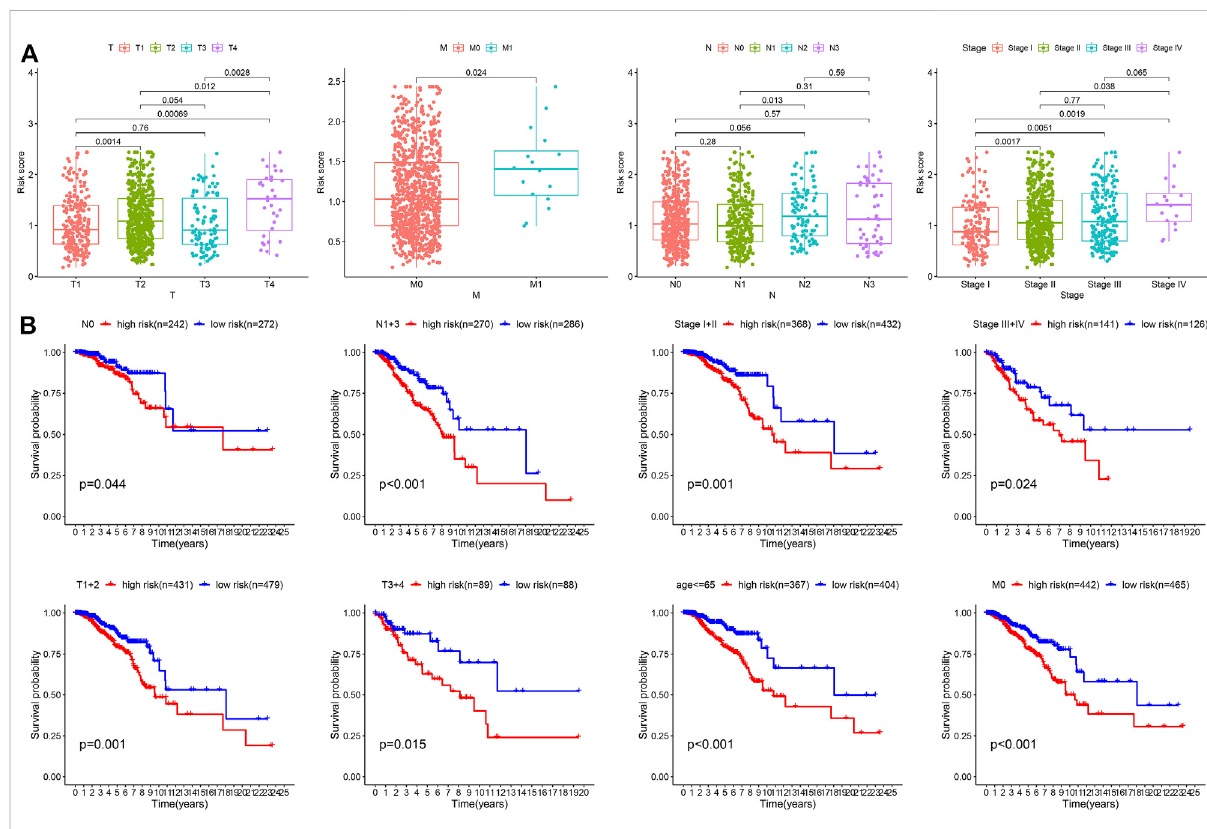
FIGURE 7 Clinical correlation and strati fi cation analyses of the signature. (A) Correlation between the risk score and TNM and tumor stages. (B) Strati fi ed survival analysis between high- and low-risk